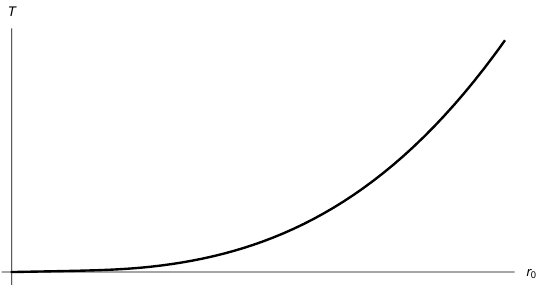
Figure 5 . T ( r 0 ) for negative